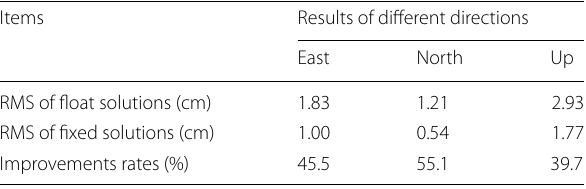
Table 1 Hourly static PPP positioning RMS and ambiguity success fixing rate